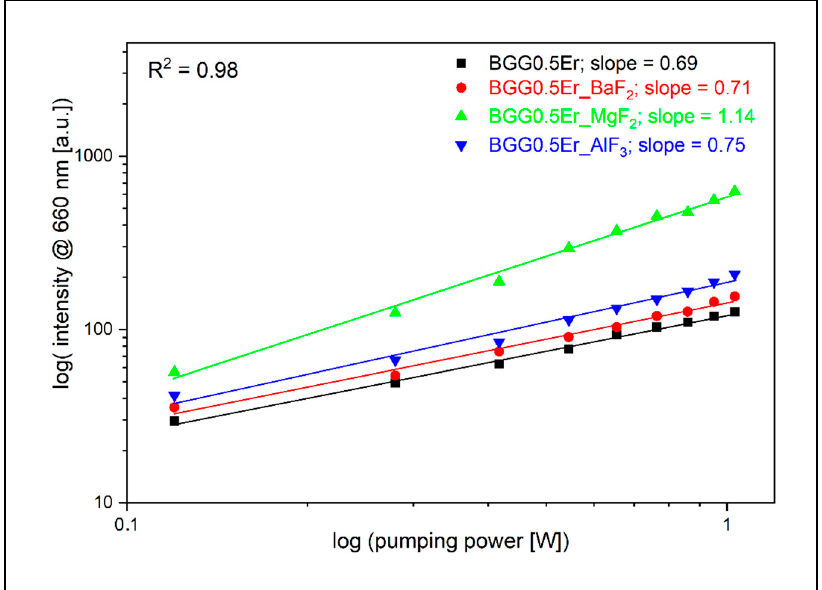
Figure 19. Log–log plot of up-conversion emission at 546 nm of fabricated glasses.